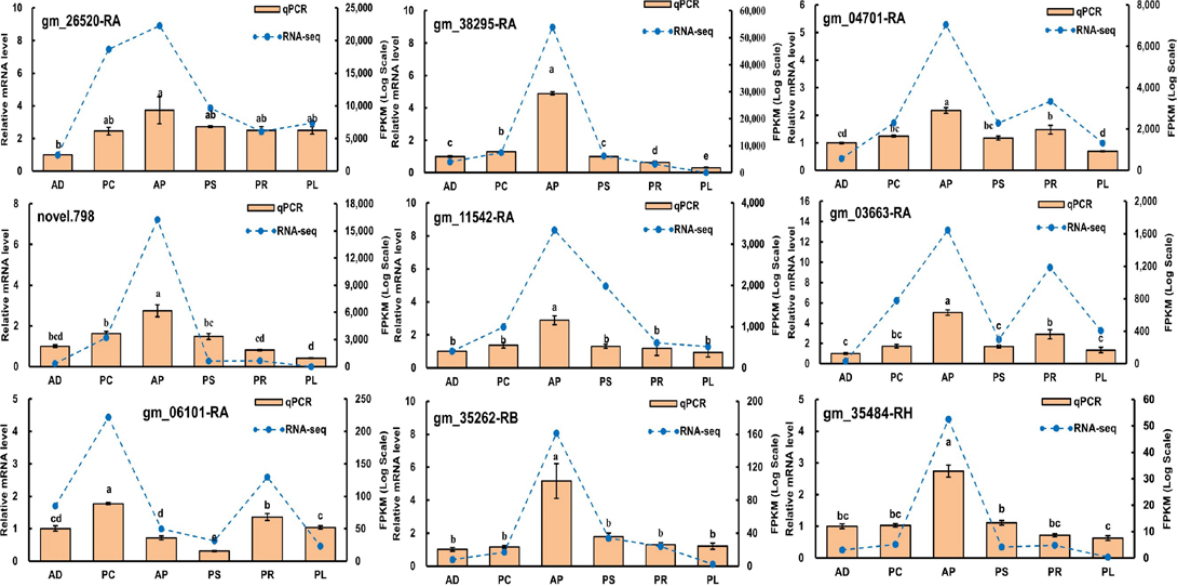
Figure 9. Validation of gene expression by qRT-PCR of selected genes. Different lowercase letters indicate significant differences among treatments ( p < 0.05). Orange bars indicate the relative expression level (Y-ordinate on left) and the blue lines represent the FPKM values (Y-ordinate on right).